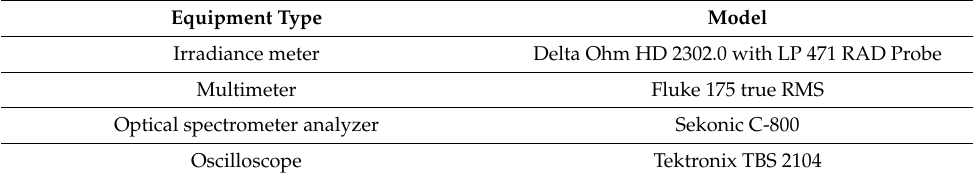
Table 5. Equipment used during the